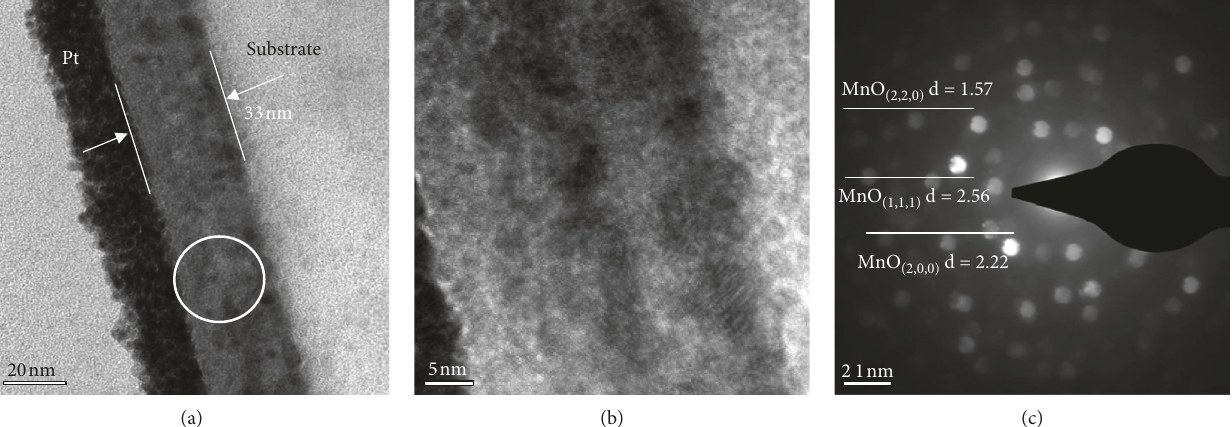
Figure 3: CuMn film TEM micrographs with 8.7 at.% Y addition annealed at 300 ° C: (a) cross-section bright field, (b) selected-area electron diffraction, (c) SAD analysis, and (d) HRTEM